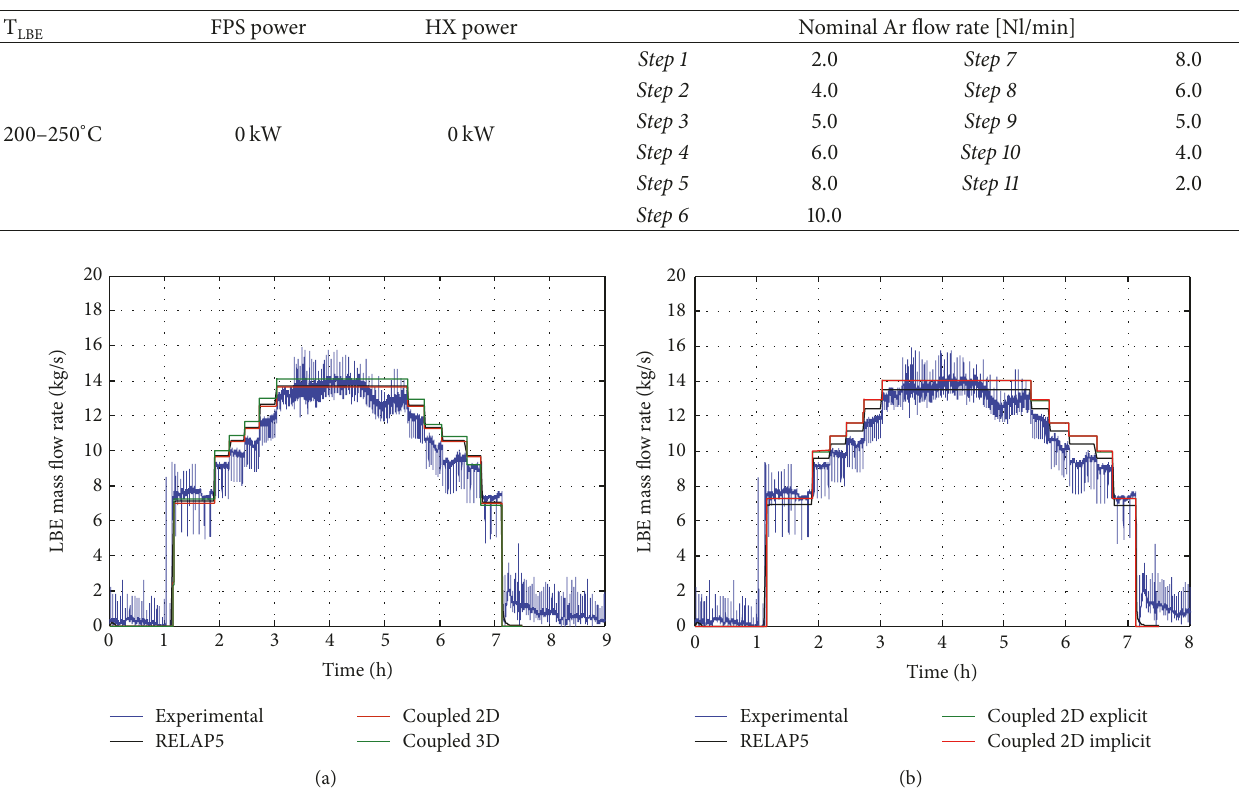
Table 1: Boundary conditions of Test 206 in NACIE facility.